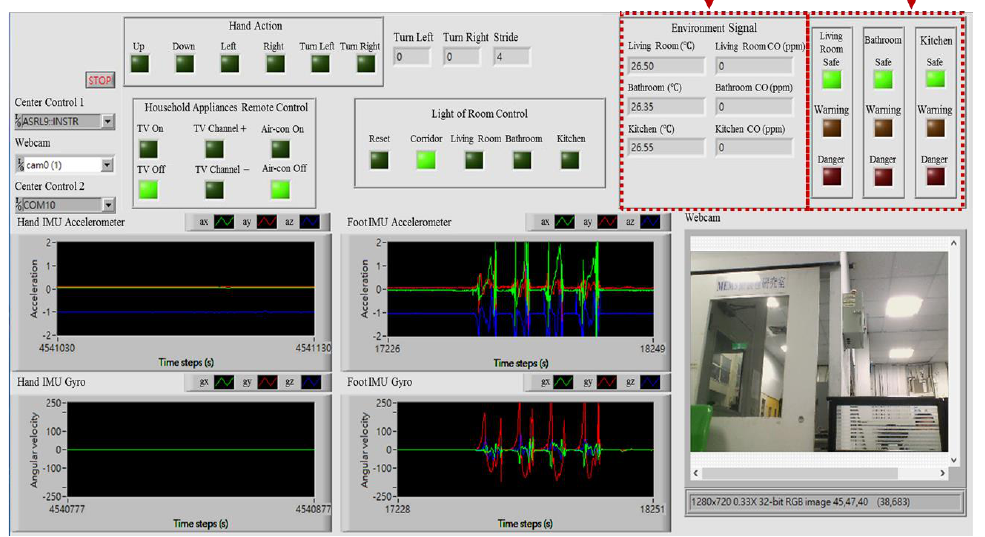
Figure 20. Temperatures, CO concentrations, and environmental conditions of the indoor environment shown on the intelligent monitoring interface.